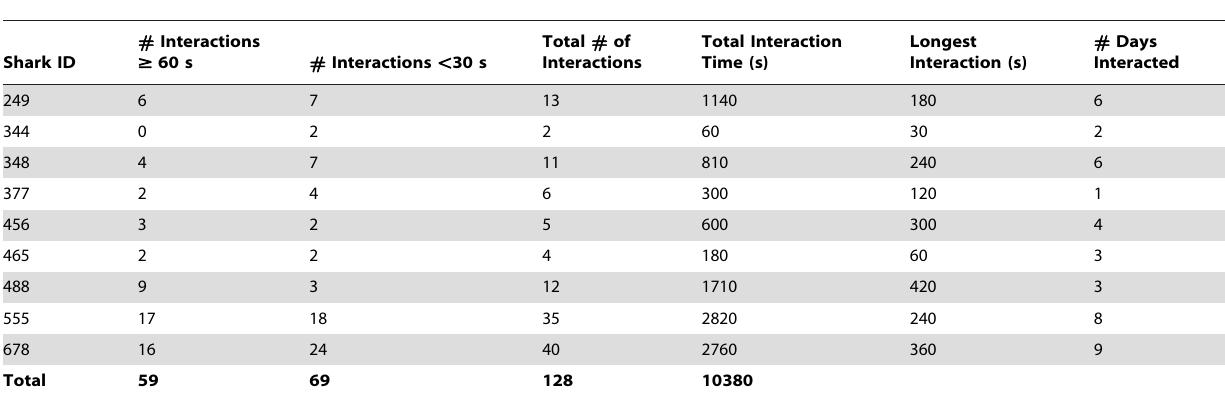
Table 2. Summary data of shark 365’s interactions with other transmitter-tagged lemon sharks, over 14 days.